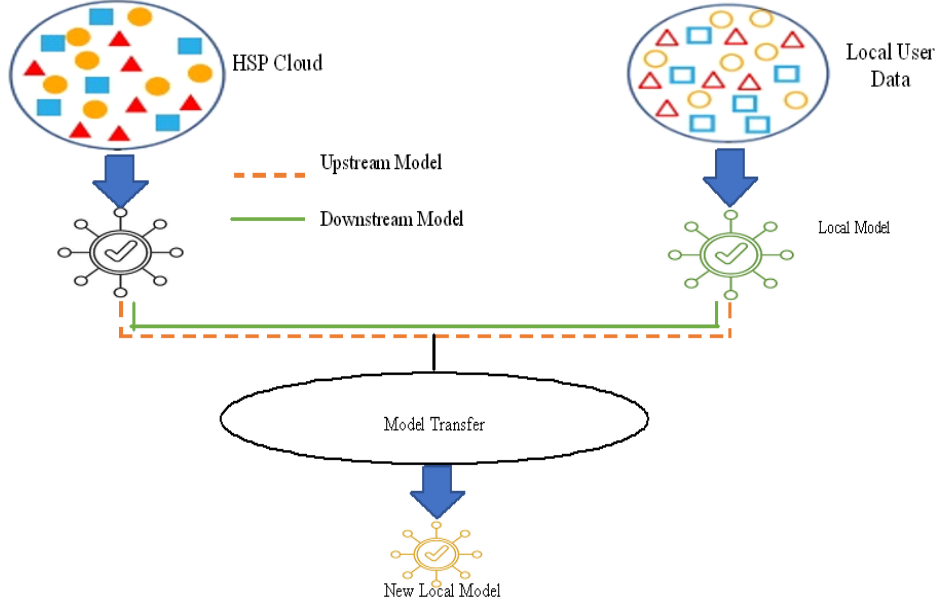
Figure 2. Illustration of model computation at HSP global model orchestrator and user ends.